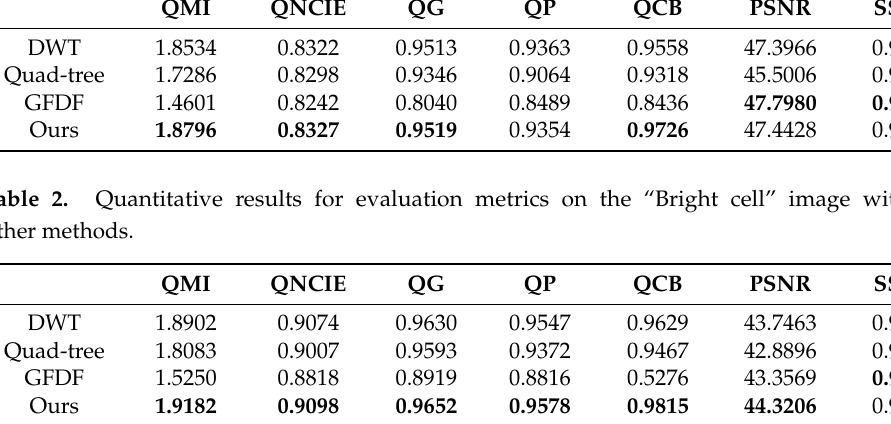
Figure 5. Fused image results generated by different methods. The top row contains the “Dark cell” image set. The bottom row contains the “Bright cell” image set. ( a ) DWT, ( b ) quad-tree, ( c ) GFDF, and the ( d ) proposed method.